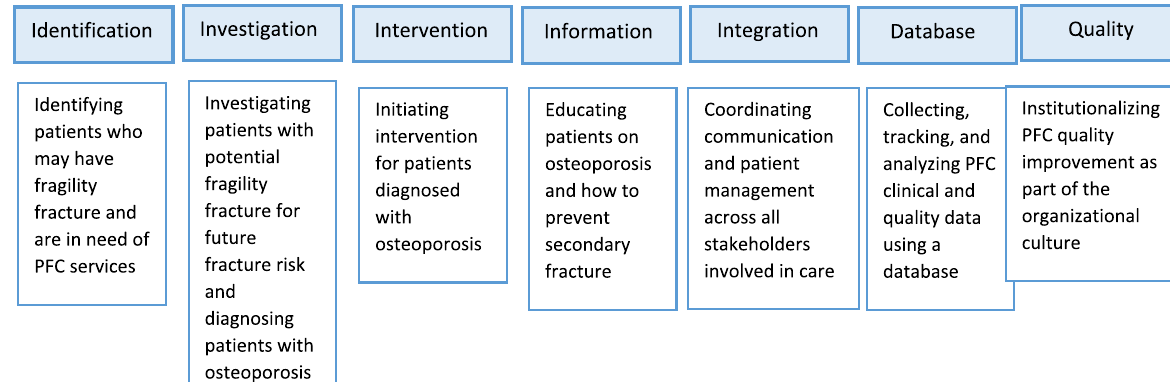
Fig. 1 The 7 elements (clinical standards) of highly functioning PFC